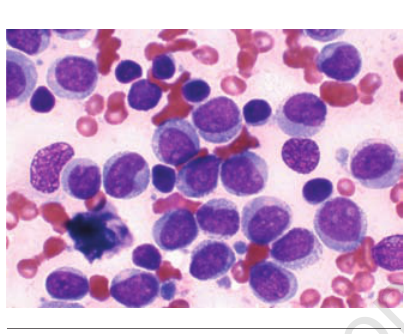
Figure 2. Bone marrow aspirate smears showing large blasts with monocytic fea- tures and few small lymphomatous cells in the background, Wright-Giemsa, 100X.